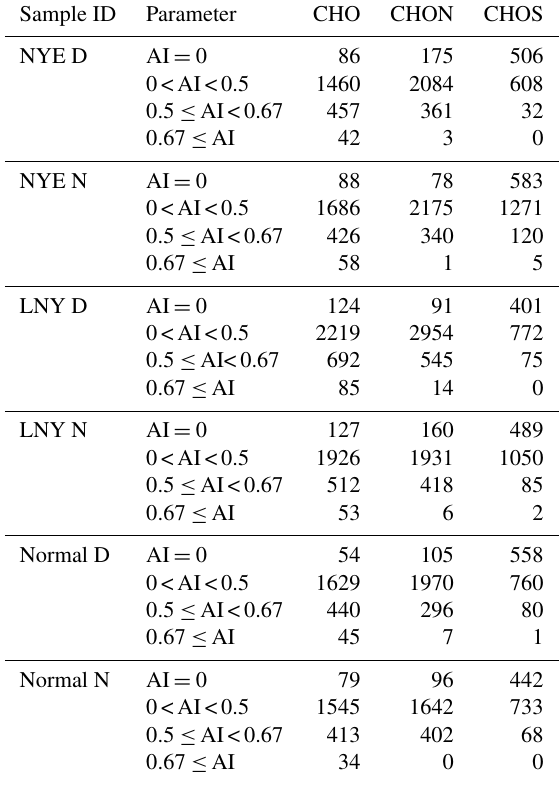
Figure 6. Overlaid carbon oxidation state (OS C ) symbols for CHO compounds in NYE D (a) , NYE N (b) , and LNY D (c) sam- ples. The size and color bar of the markers reflect the relative peak intensities of compounds on a logarithmic scale. The gray areas were marked as SV-OOA (semivolatile oxidized organic aerosol), LV-OOA (low-volatility oxidized organic aerosol), BBOA (biomass burning organic aerosol), and HOA (hydrocarbon-like or- ganic aerosol) (Kourtchev et al., 2016; Kroll et al.,